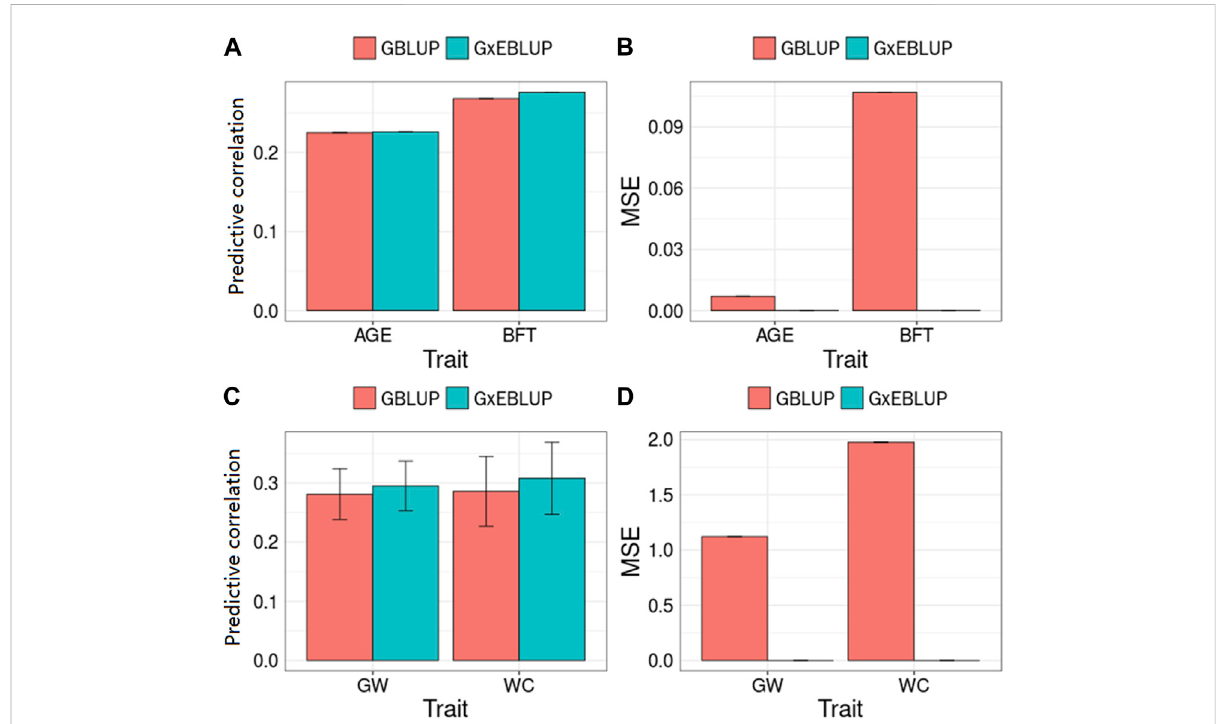
FIGURE 3 GBLUPandG×EBLUPmethodforthe (A,C) accuracyand (B,D) meansquarederror(MSE)ofgenomicpredictioninpigsandmaize.AGE:daysto 100 kg; BFT: backfat thickness adjusted to 100 kg; GW: grain weight; WC: water content. MSE is a relative value by assuming that the MSE of GBLUP method is equal to 0 because of the large MSE